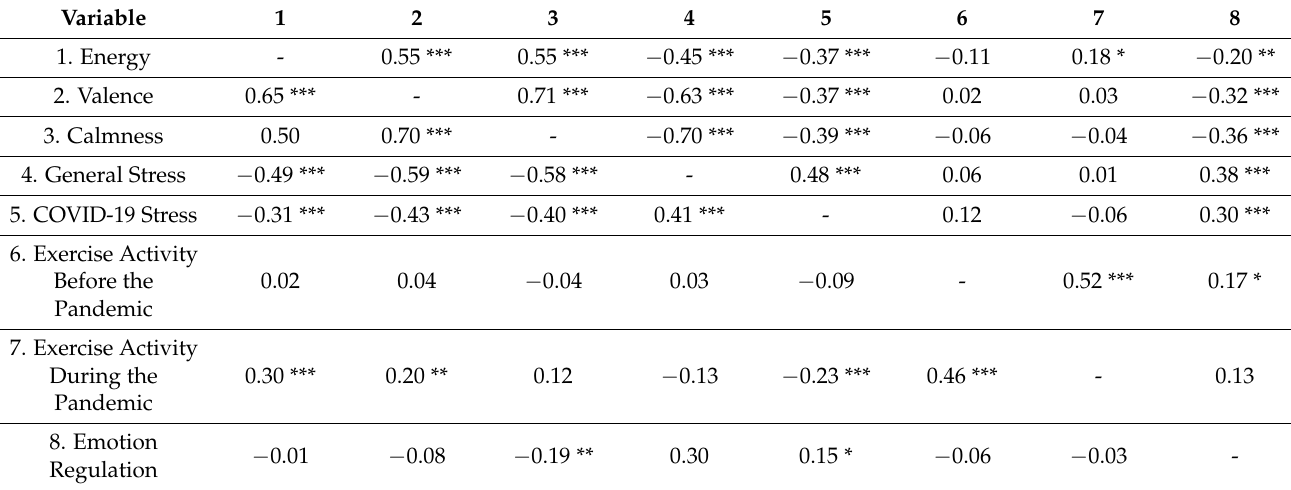
Table 3. Intercorrelations for study variables disaggregated by